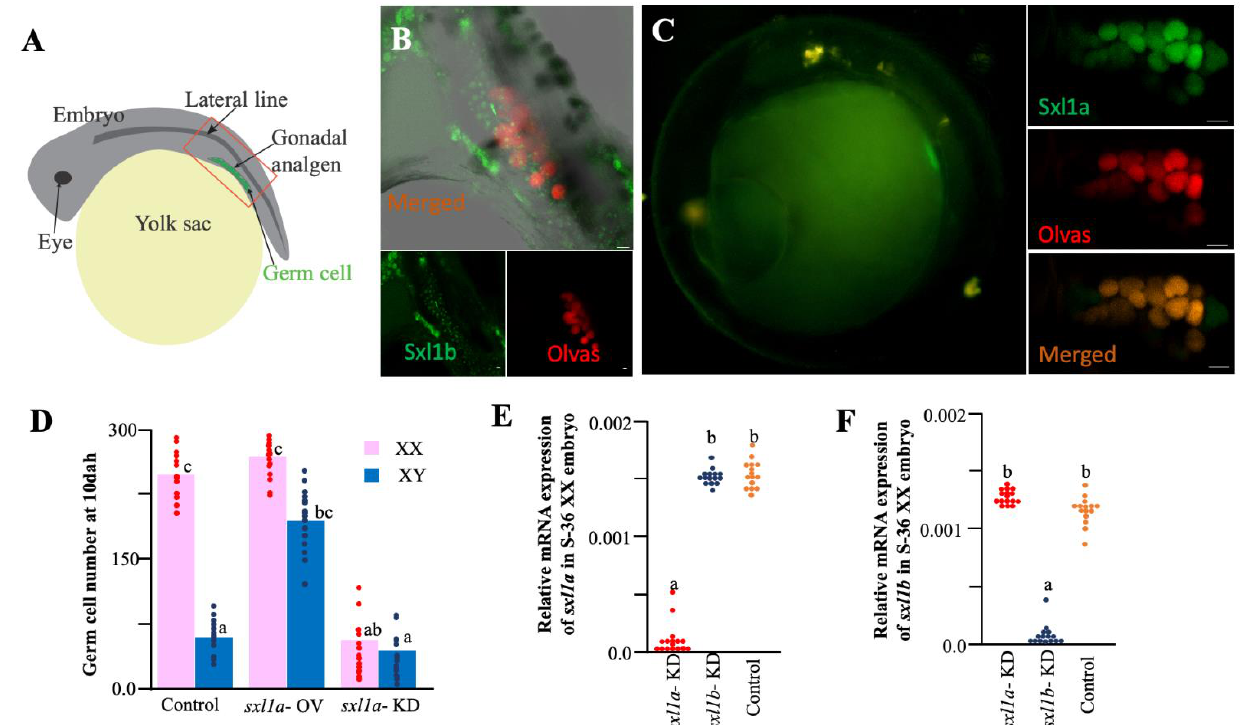
Figure 4. Functional analysis of sxl1a and sxl1b in medaka embryo. We evaluated the GFP localization in gonadal analgen and its nearby regions (“Region of Interest” marked with red box) of overexpressed embryos ( A ). When overexpressed, Sxl1b-GFP were concentrated in various embryonic body parts at 3daf ( B ), while Sxl1a-GFP were specifically congregated in the PGCs of Olvas-dsRED transgenic medaka at 3 DAF ( C ). 15 overexpressed and knockdown embryos were raised till 10 DAH, and germ cells were counted using serial sections of bouin fixed samples ( D ). At 10 DAH, the total germ cells were significantly increased and dramatically reduced in XY- sxl1a -OV and XX- sxl1a -KD embryos, respectively ( D ). Average germ cell numbers at each stage were plotted as columns, and each dot represents one individual. Further, changes in sxl1a ( E ) and sxl1b ( F ) mRNA abundance were measured using sxl1a -KD, sxl1b -KD, and control embryos at S-36 (15 XX embryos/group) and plotted onto graphs. Each dot represents one individual. Note: Different letters denote significant differences at p < 0.05; pictures are general representations from 15 individual observations. Bar length-10 µm.